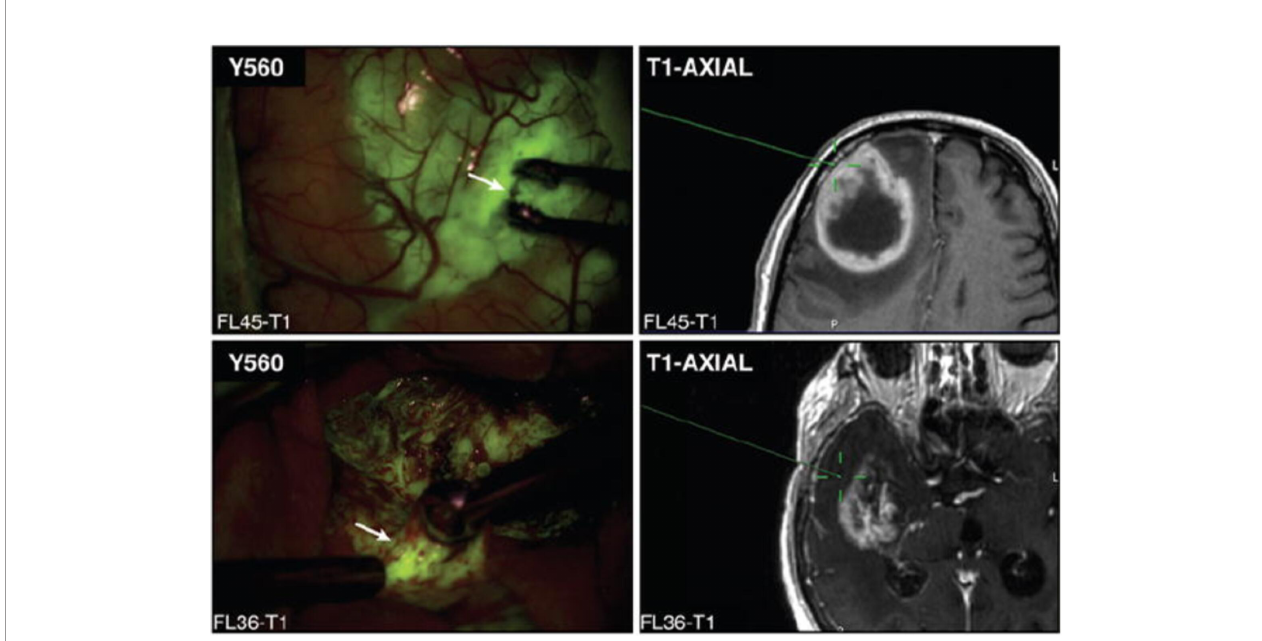
FIGURE 1 | Representative image of biopsy sites (white arrows) from both contrast-enhancing (upper) and non-enhancing (lower) regions, localized using stereotactic guidance with the BrainLab-registered wand indicating the biopsy site on preoperative MRI (green crosshairs). Note that both contrast-enhancing and non-enhancing biopsy sites demonstrate yellow-green fl uorescence. Modi fi ed from Neira JA: Aggressive resection at the in fi ltrative margins of glioblastoma facilitated by intraoperative fl uorescein guidance. Journal of Neurosurgery 127:111-122, 2017. With permission from Journal of Neurosurgery Publishing